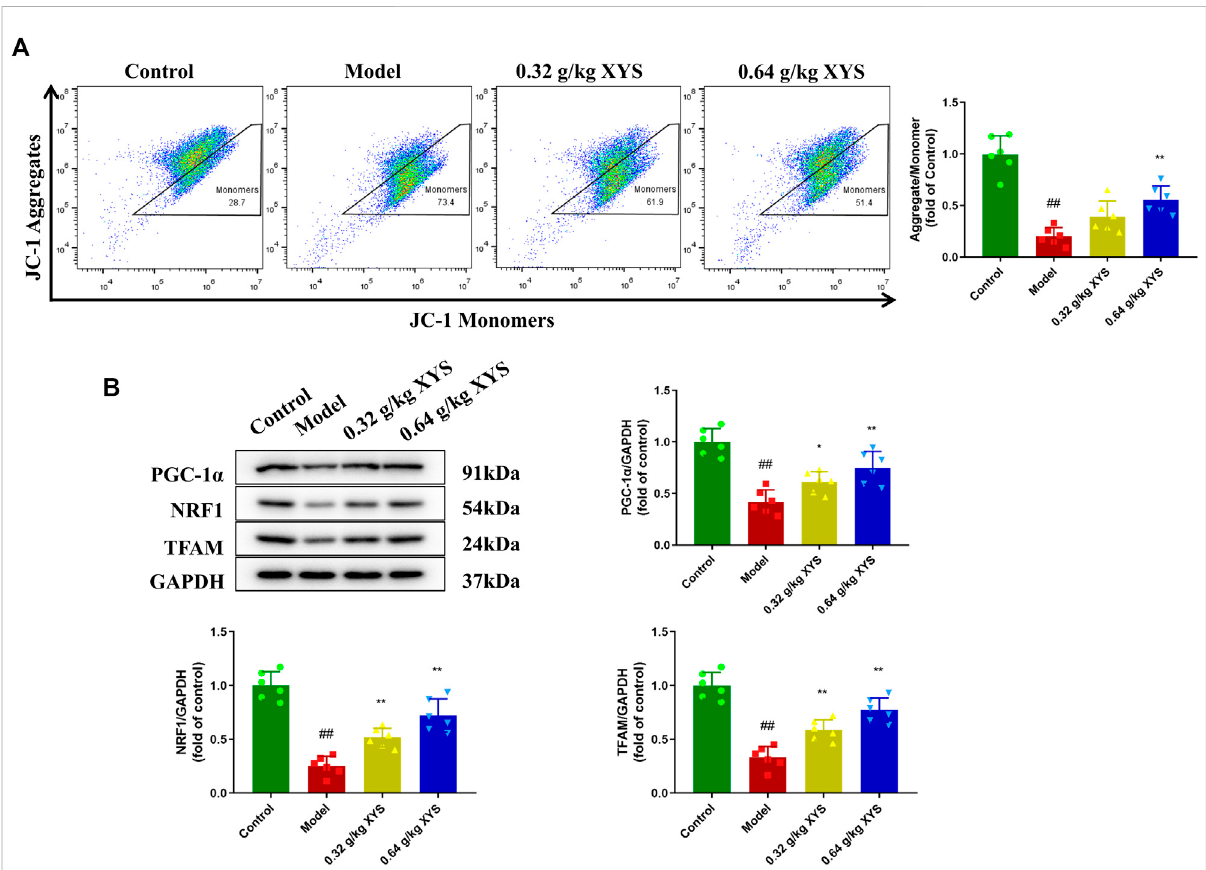
FIGURE 5 Detection of mitochondrial membrane potential and expression of mitochondrial synthesis-related proteins. Mice were treated with XYS (0.32or0.64 g/kg) via gavageforthreeconsecutivedaysandsacri fi cedonthefourthday. (A) Thepotentialofthecellmitochondrialmembranefrom liver tissue homogenates in each group was detected using fl ow with a JC-1 probe. (B) Representative images of Western blot analysis of PGC-1 α , NRF1, and TFAM and their relative quantitative histograms. GAPDH was used as an internal control. # p < 0.05 vs. Control group, and ## p